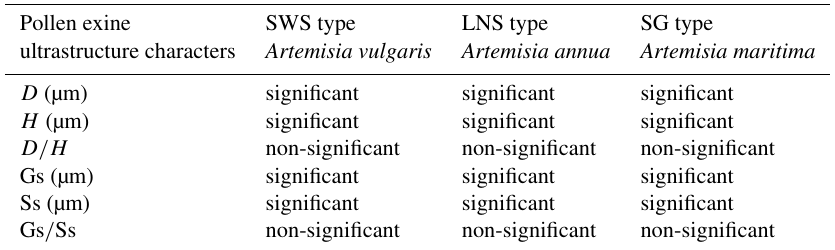
Table 2. The results of ANOVA for intraspecific variability in pollen exine ultrastructure characters among three representative